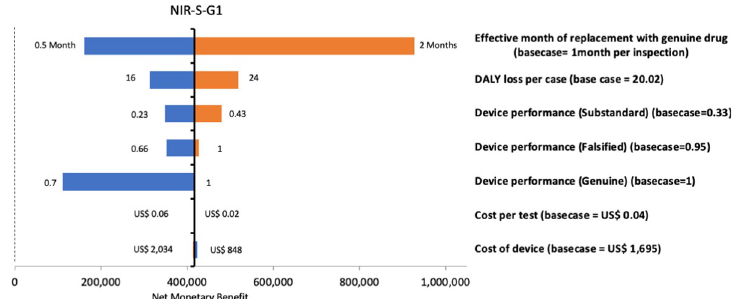
Fig 5. Tornado diagram illustrating one-way sensitivity analyses with a range of plausible parameter values for key model parameters, in a lower prevalence scenario for the NIR-S-G1 device (blue bars represents scenarios with lower parameter estimates, orange bars represent scenarios with the higher parameter estimates, and dotted vertical line represents the cost-effectiveness threshold).